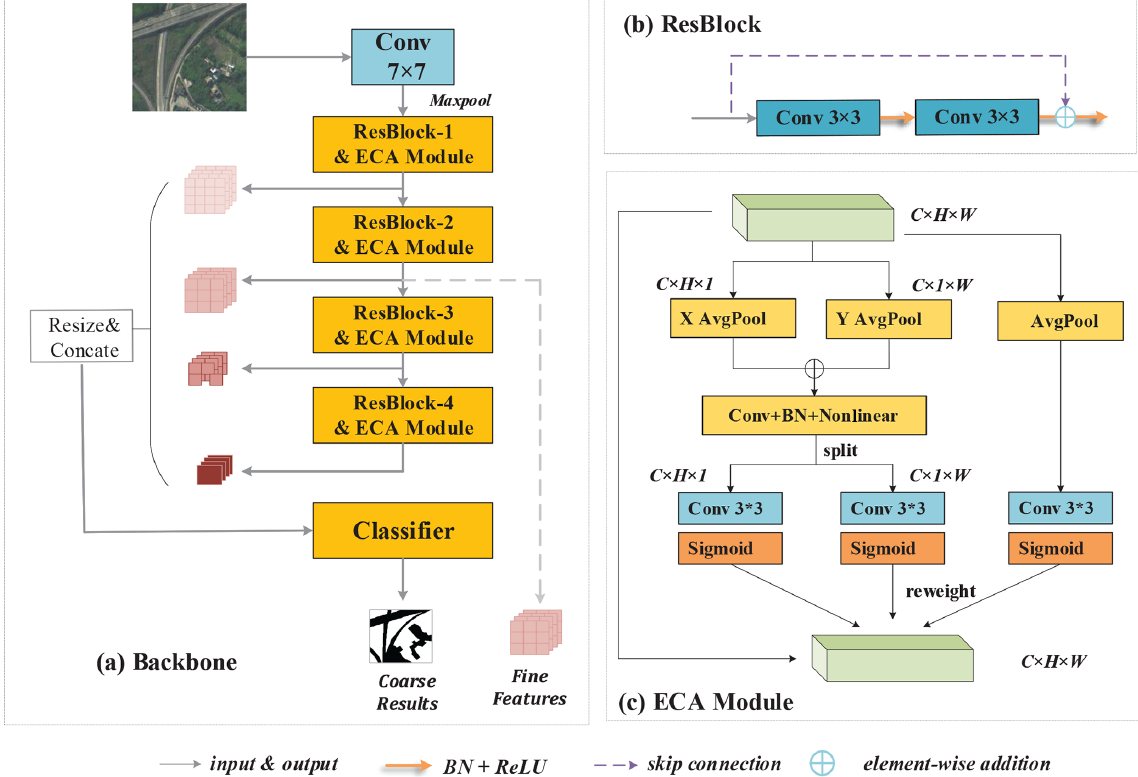
Figure 6. Architecture of the backbone in UGSNet. The image was retrieved from © Gaofen-2 2019. (a) Backbone overview. (b) Sketch diagram of the ResBlock. (c) ECA module.